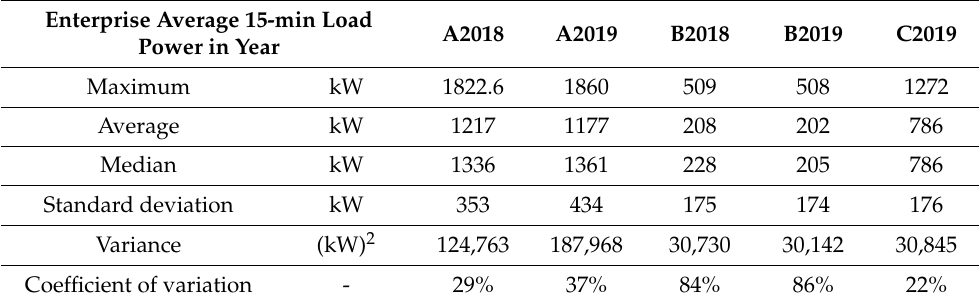
Table 1. Statistical data of the 15-min load power time series of the researched enterprises.